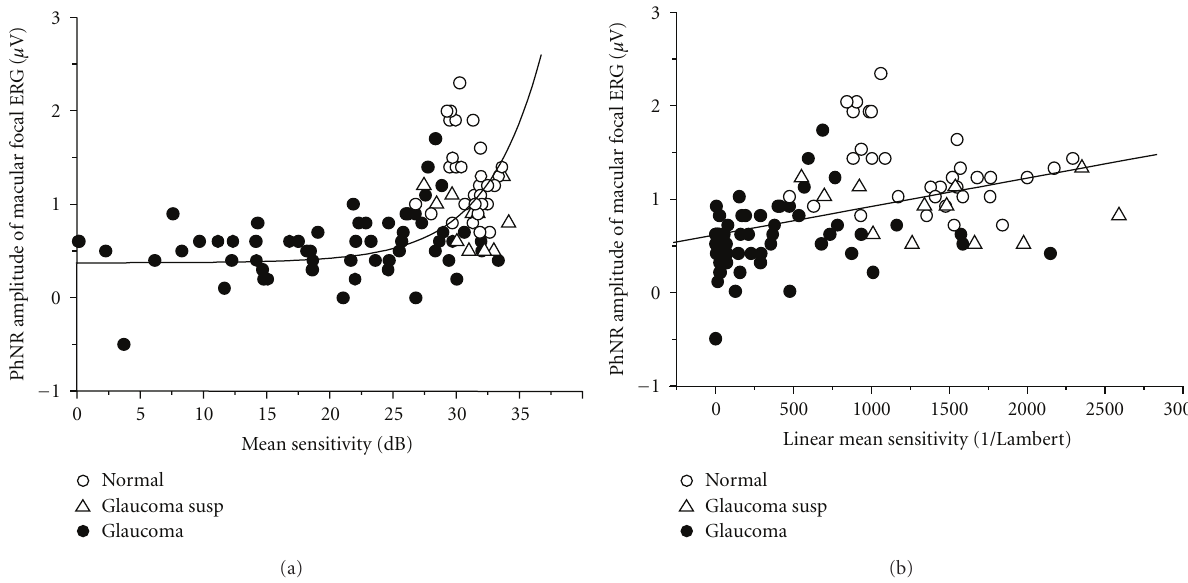
Figure 9: (a) The PhNR amplitude of the focal macular electroretinogram was plotted against mean visual sensitivity (dB) obtained by standard automated perimetry 10-2 program. The fitting curve was obtained by the equation based on Hood model [29, 30]. (b) The mean visual sensitivity (dB) was converted to a linear value (1/Lambert). PhNR: photopic negative response (reproduced with permission from